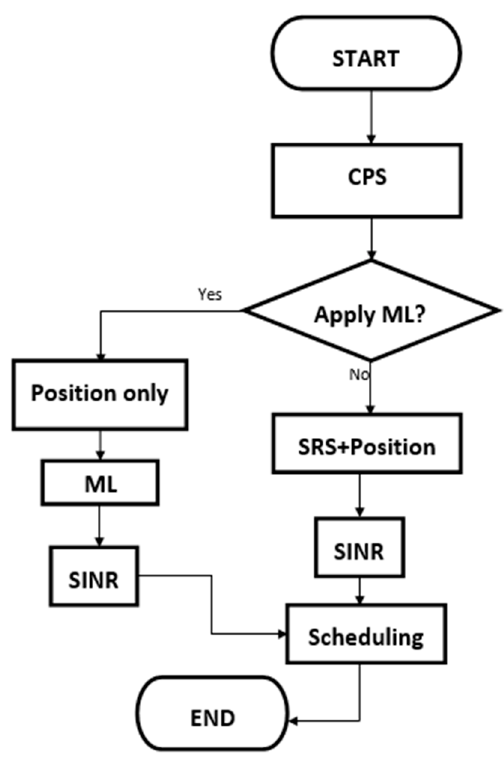
Figure 8. Flow chart for implementation of the proposed scheme.